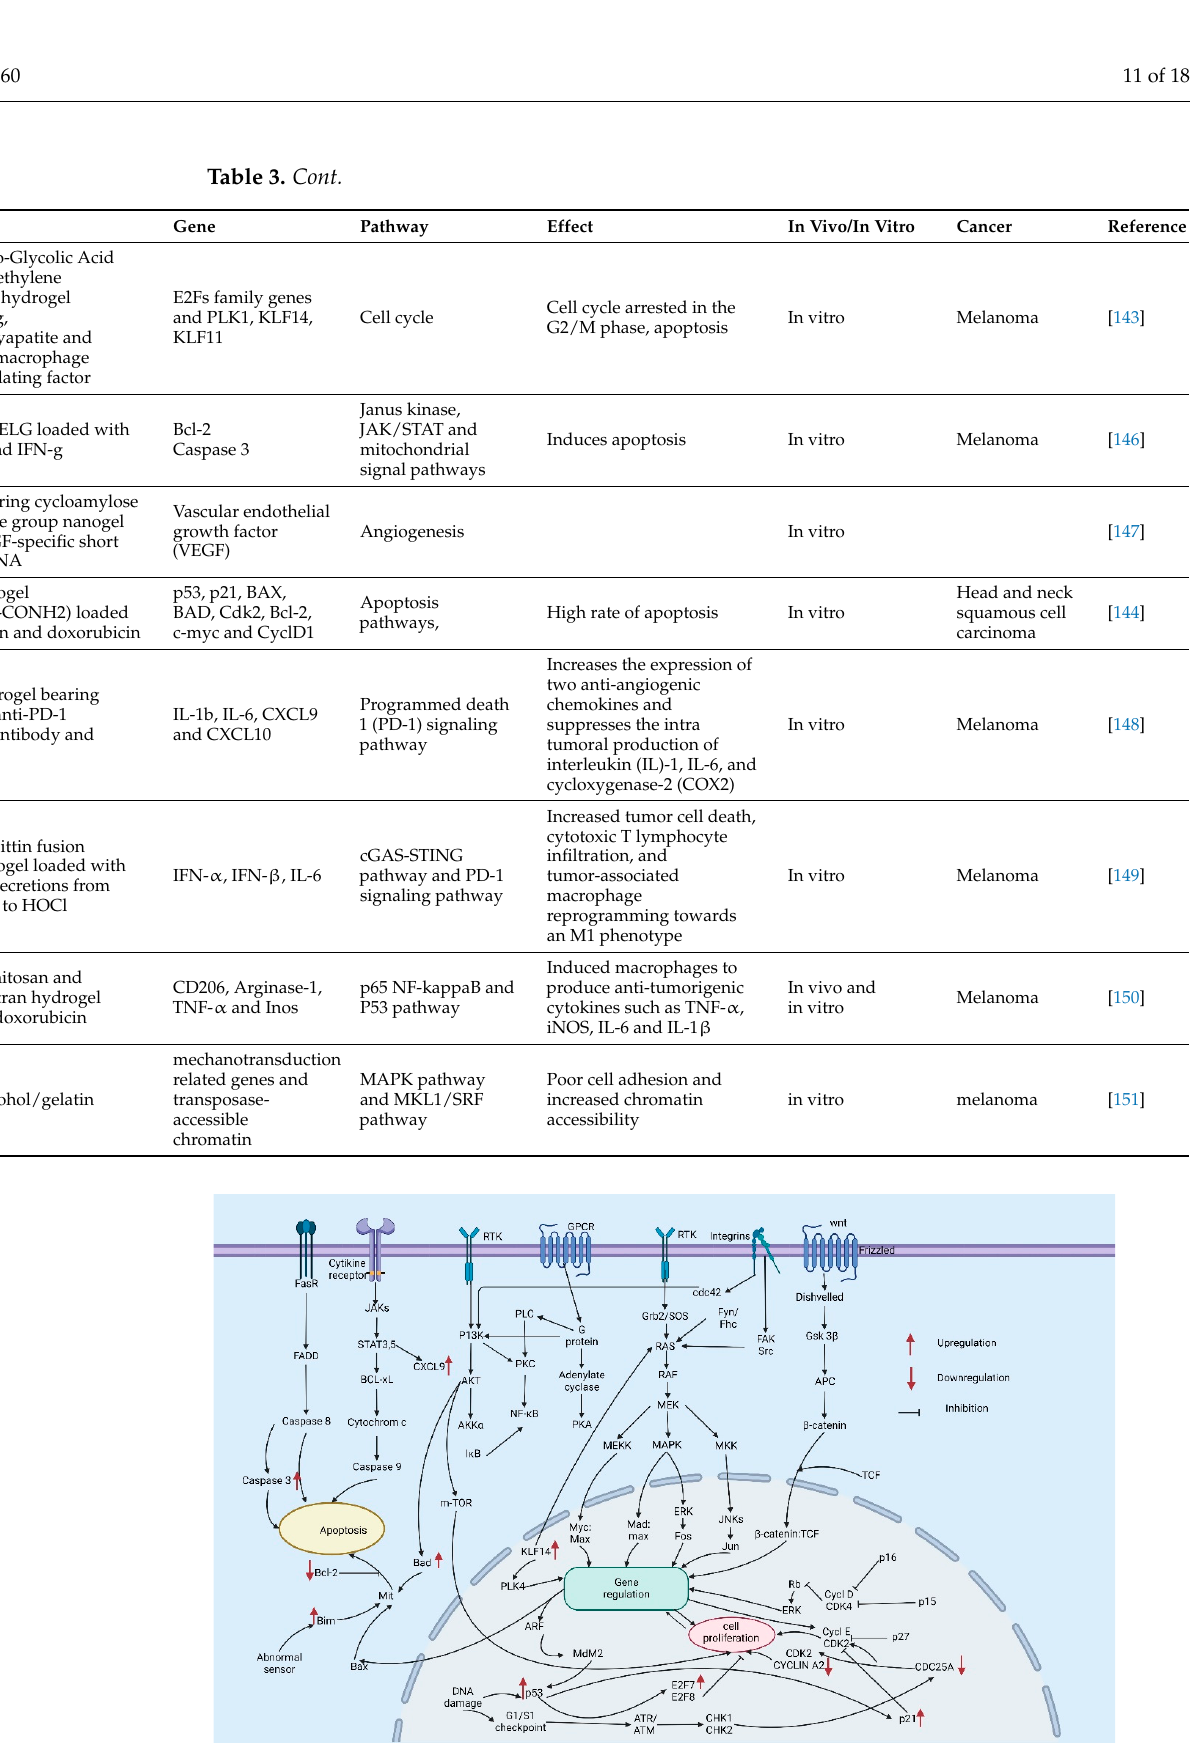
Figure 2. Gene regulations on hydrogel mediated drug delivery treatment for skin cancers,